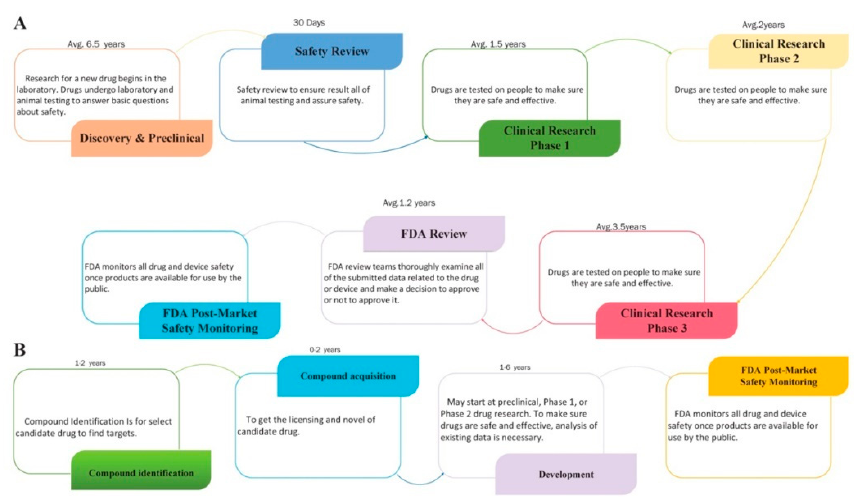
Figure 1. Differences between traditional ( A ) and reposition ( B ) drug development. From [4], under open access (CC BY-NC) .